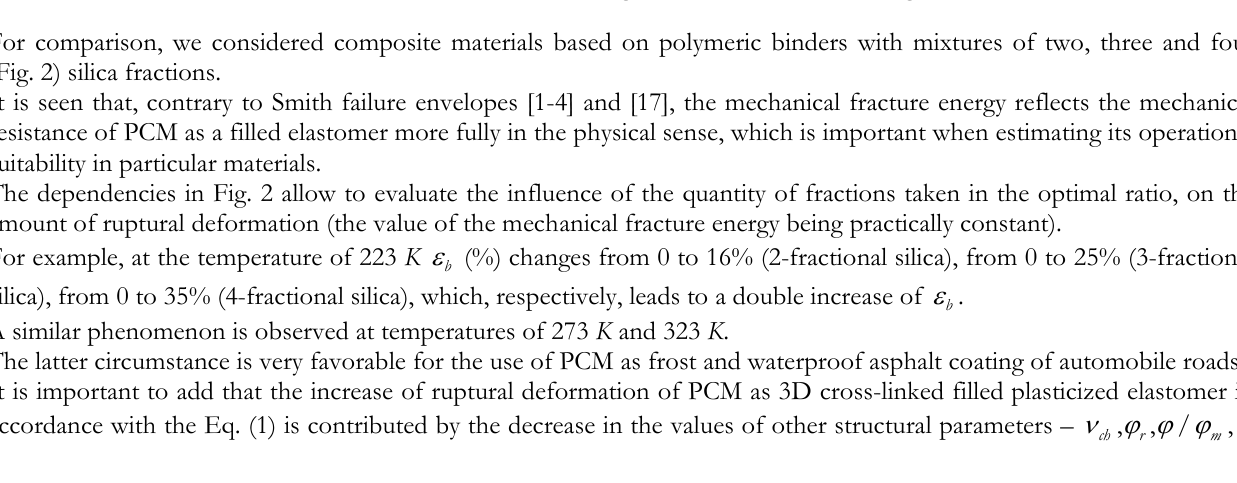
Т able 4: Initial data for calculating the mechanical fracture